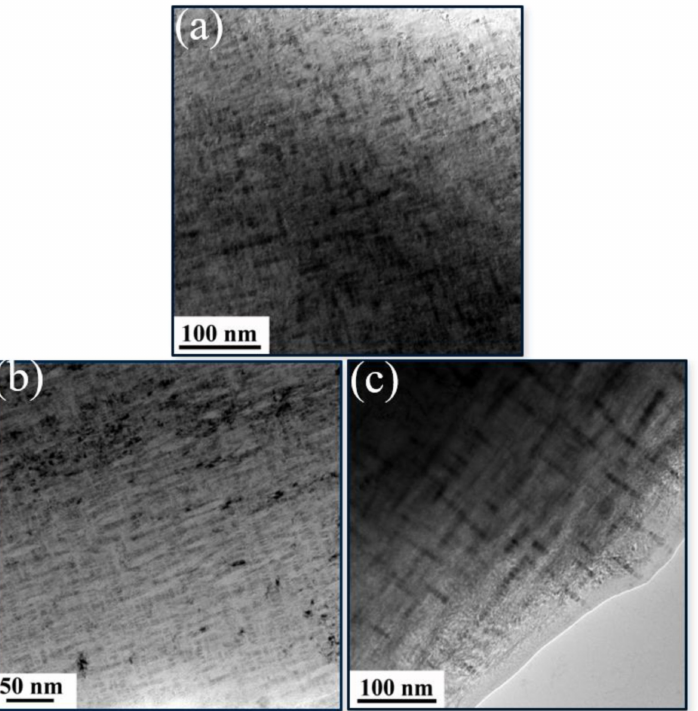
Figure 5. TEM bright-field images of the three alloys after being aged at 973 K for 6 h: ( a ) TZT1, ( b ) TZT2 and ( c ) TZT3.